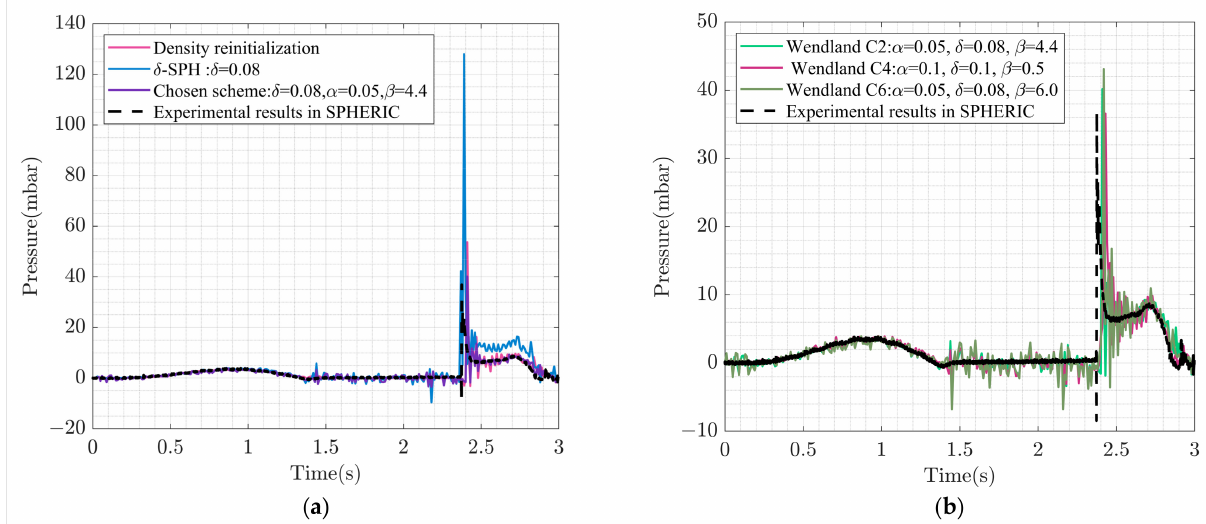
Figure 9. ( a ) Comparison of the interpolated pressure data at the measurement location against the experimental measure- ments for different numerical dissipation schemes with the WC2 kernel. ( b ) Comparison of the interpolated pressure data using the chosen numerical scheme for different Wendland